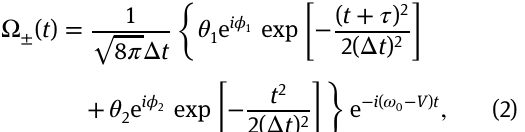
Figure 2: Level structure of the model. (a) Three-level system (3LS) in a V-shape including scattering between the excited states. (b) Reduced two-level system (2LS) considering only one polarization